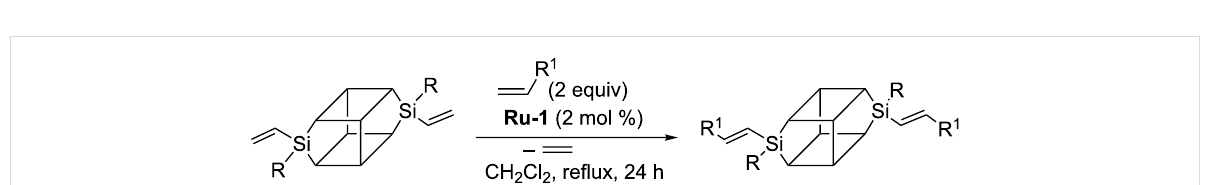
Scheme 10: Cross metathesis of monovinylgermasilsesquioxane with styrenes.